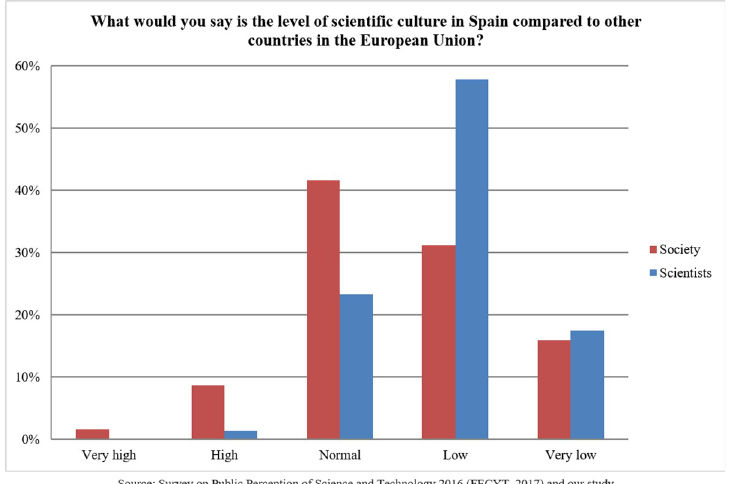
Fig 6. The perceived level of scientific culture in Spain compared to other European countries by society in general (FECYT data) and scientists (our data).